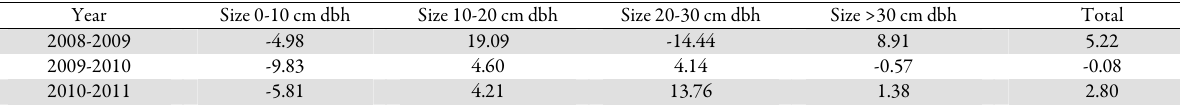
Tab. 5. Basal area changes (%) in the Kagekanu permanent vegetation